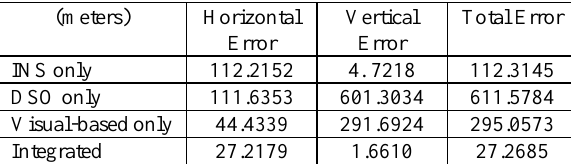
Table 7. Position error in the end point of different